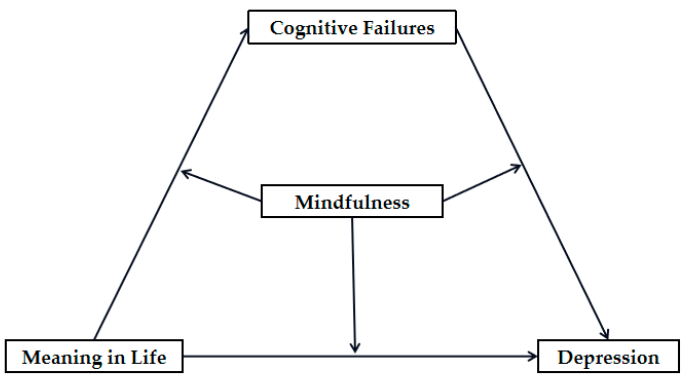
Figure 1. The proposed moderated mediation